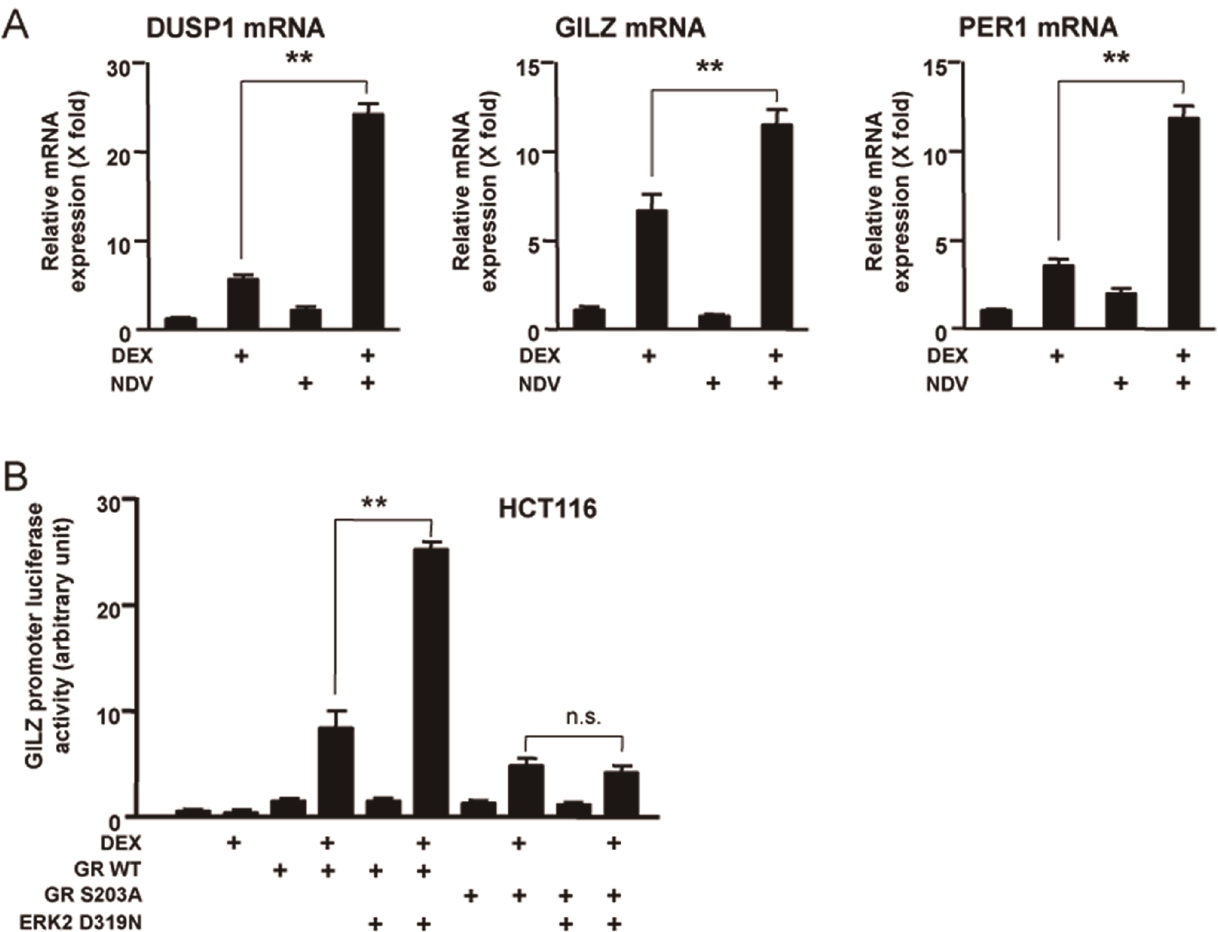
Figure 8. NDV increases DEX-induced expression of several glucocorticoid-responsive genes through phosphorylation of GR. A . NDV increased DEX-induced mRNA expression of 3 well-known glucocorticoid-responsive genes in DCs. DCs were pre-treated with DEX (10 2 6 M) for 30 min, and were infected with NDV (MOI=10) for 6 hours. mRNA levels of DUSP1 , GILZ and PER1 were measured in the real-time qPCR. Bars represent means and standard errors of fold changes of their mRNA expression obtained in three independent experiments. **: p , 0.01, compared the 2 conditions indicated. B : ERK2 increased DEX-induced transcriptional activity of the GILZ promoter in the presence of wild type human GR in HCT116 cells, while it lost the effect in the presence of the mutant GR harboring S203A replacement. HCT116 cells were transfected with ERK2 D319N- expressing plasmid in the presence of wild type human GR or its mutant with S203A replacement, together with the pGILZ-luc reporter and the pGL4.73[ hRluc /SV40] control plasmid. Cells were subsequently treated with DEX (10 2 6 M) for 24 hours. Bars represent means and standard errors of the firefly luciferase activity corrected for renilla luciferase activity. **: p , 0.01, n.s.: not significant, compared the 2 conditions indicated.